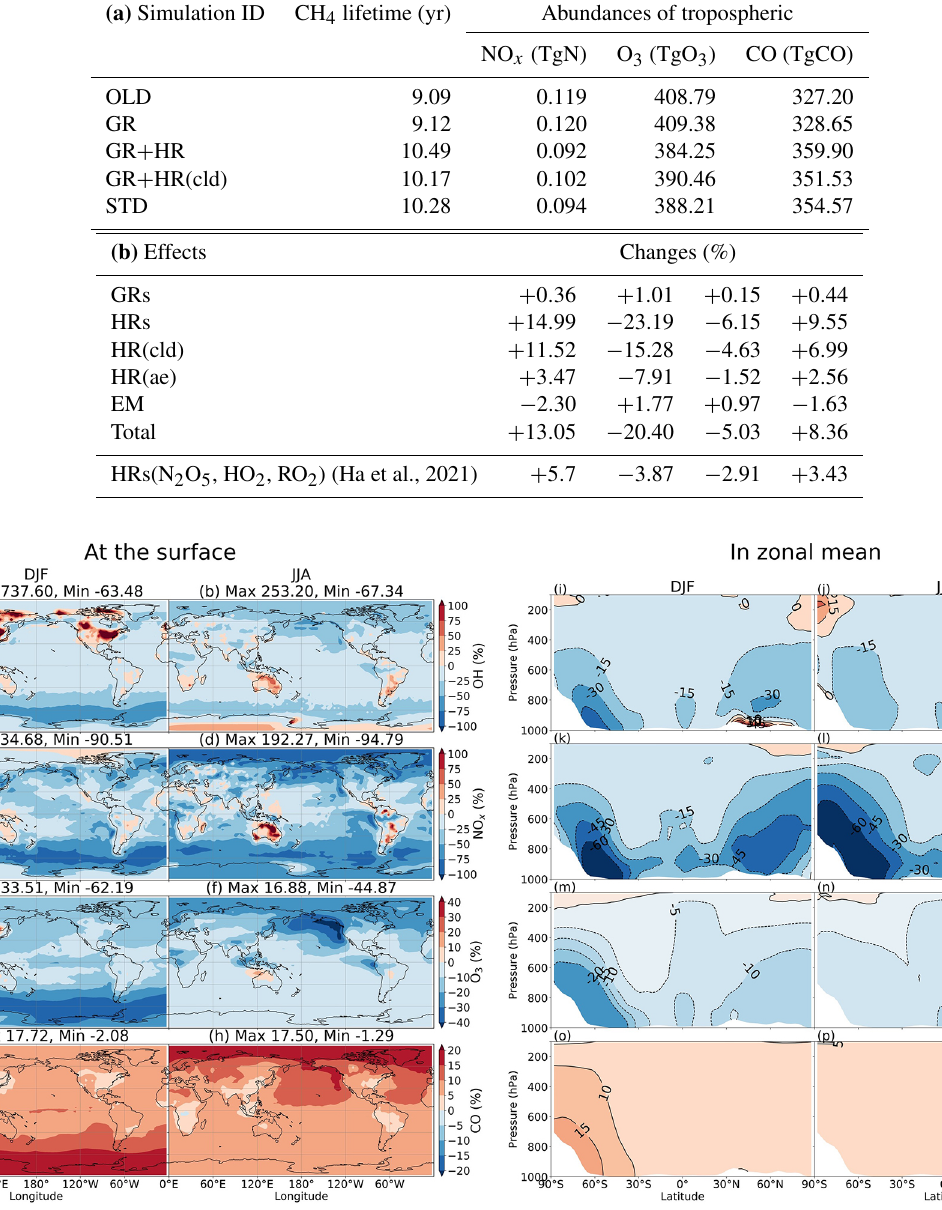
Figure 14. Effects of the HONO photochemistry on the tropospheric oxidants OH (first row of panels), NO x (second row of panels), O 3 (third row of panels), and (CO last row of panels). Effects at the surface (a–h) and zonal means (i–p) are